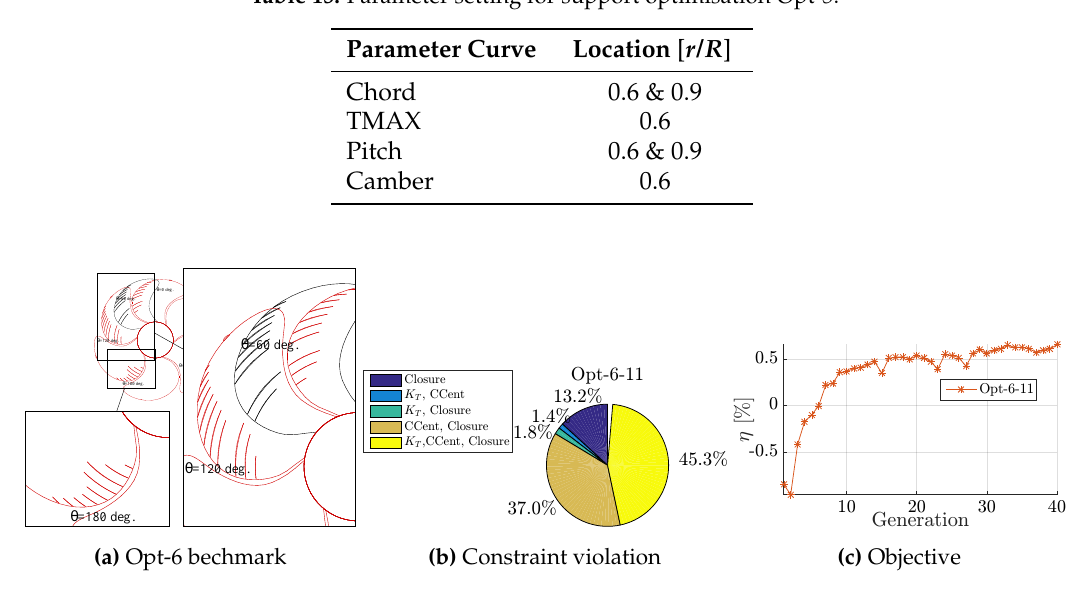
Table 15. Parameter setting for support optimisation Opt-5.